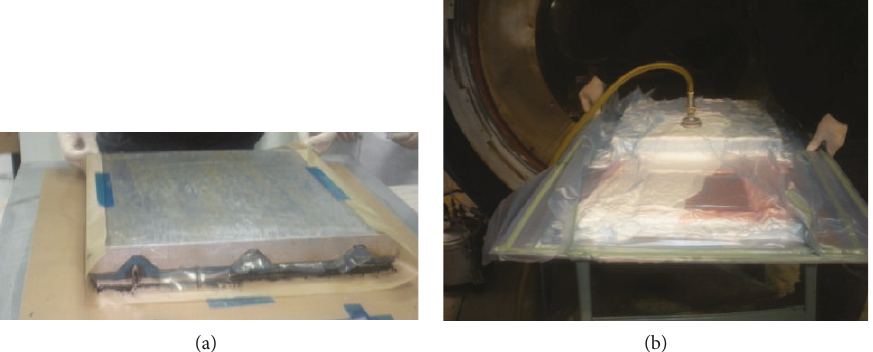
Figure 13: (a) Placing of a rigid metal outer mold and (b) vacuum bag and cure in the autoclave.